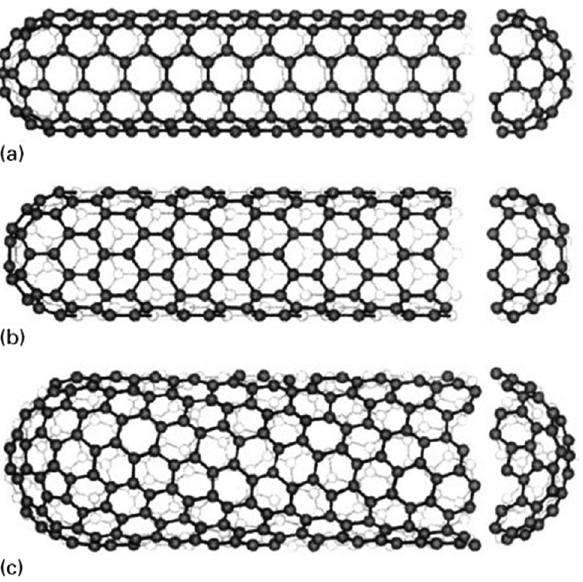
Figure 3: Di ff erent structures of CNTs [ 4 ] : ( a ) SWCNTs and MWCNTs with armchair structure and ( b ) SWCNTs and MWCNTs with zigzag